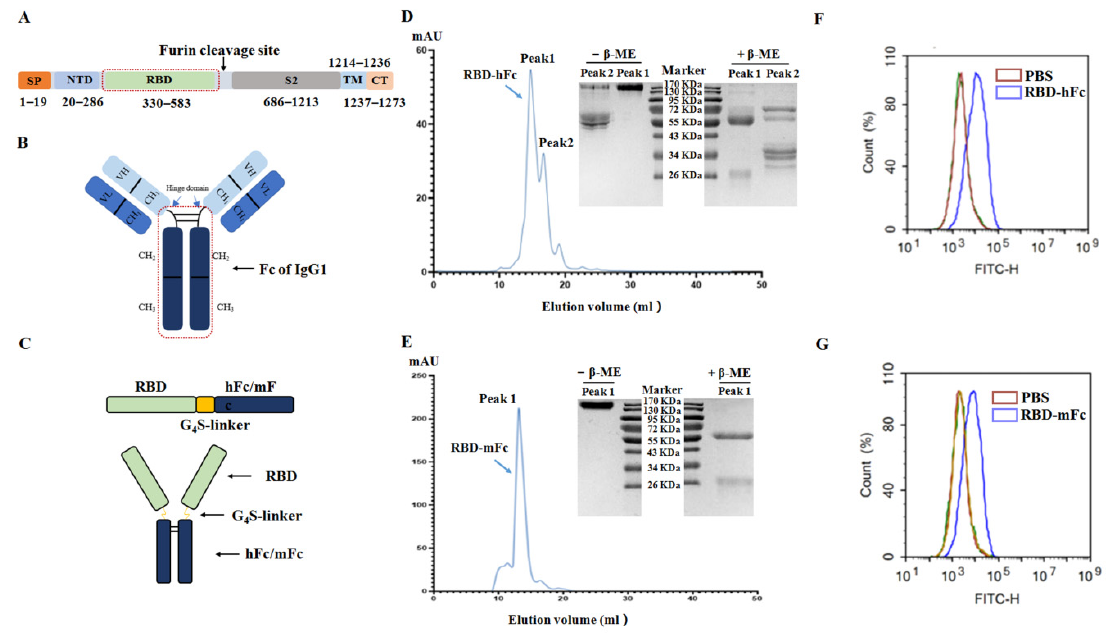
Figure 2. Construction and characterization of SARS-CoV-2 RBD recombinant proteins. ( A ) A schematic view of the SARS-CoV-2 S protein. RBD ranges from 330 to 583 aa of the SARS-CoV-2 S protein. SP, signal peptide; NTD, N-terminal domain; TM, transmembrane; CT, C-terminal domain. ( B ) Structure diagram of IgG1. Fc contains the hinge domain, CH 2 and CH 3 . ( C ) A schematic view of the SARS-CoV-2 recombinant protein. Residues 330–583 aa of the SARS-CoV-2 S protein were fused with a modified Fc fragment of human IgG1 or mouse IgG1 (hFc or mFc) via a G 4 S (Gly-Gly-Gly-Gly-Ser) flexible linker and engineered in a mammalian cell expression system. The purification results of RBD-hFc recombinant protein ( D ) and RBD-mFc recombinant protein ( E ) after purified by the protein A/G chromatographic column and a Superdex 200 increase column. Each elution peak was analyzed by SDS-PAGE in the presence of β -mercaptoethanol ( β -ME) or not. The elution peaks of both recombinant proteins were noted with blue arrows. The cell binding ability of the RBD-hFc recombination protein ( F ) and RBD-mFc recombinant protein ( G ) were measured by flow cytometry using the Vero E6 cell line.